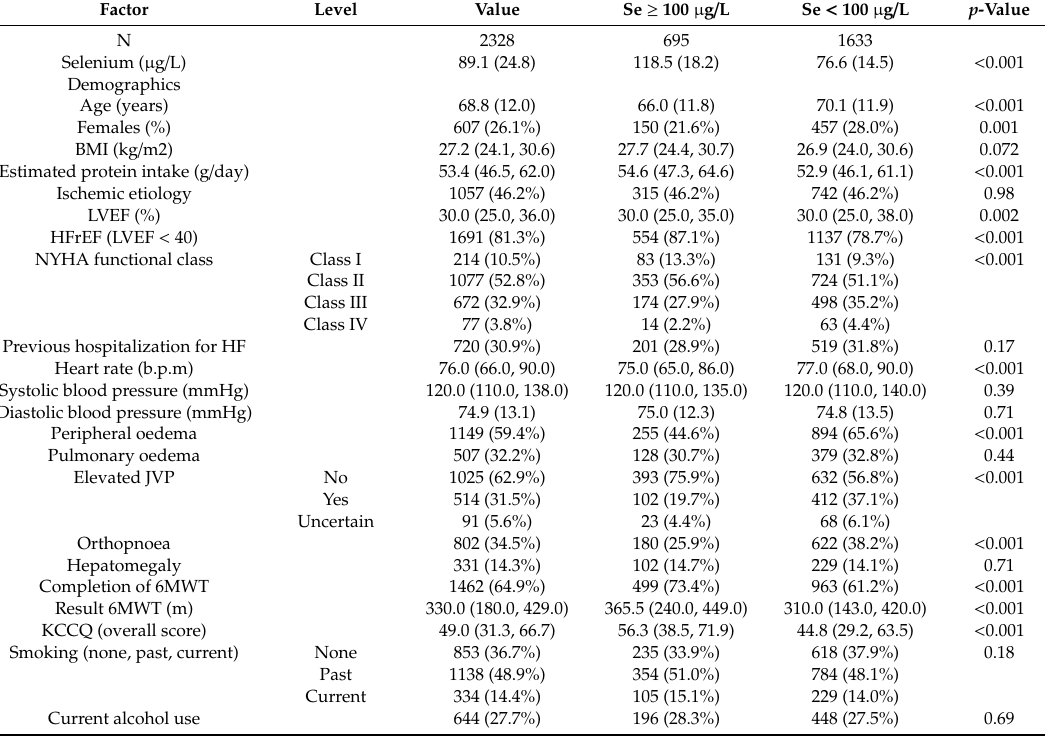
Table A2. Baseline